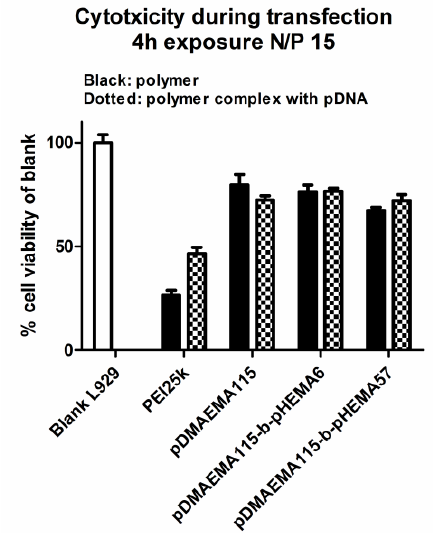
Figure 9. Cytotoxicity (MTT) of pDNA-polymer complexes, N/P 15 in L929, exposed for 4 h.